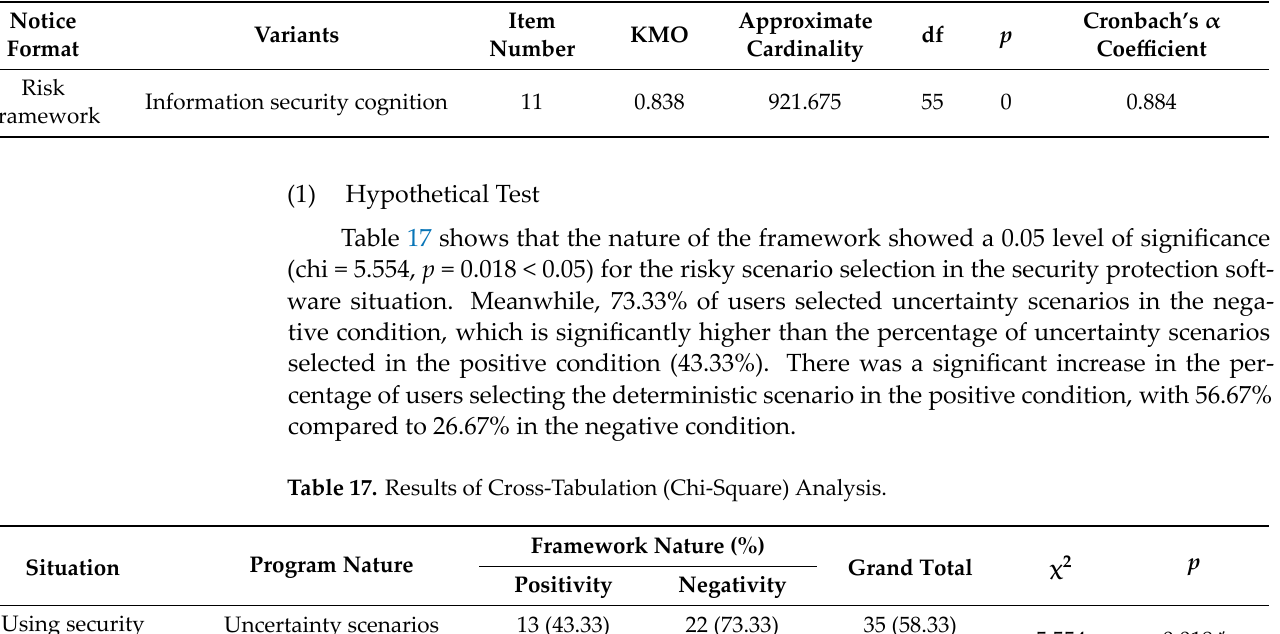
Table 16. Reliability and Validity Analysis Results.